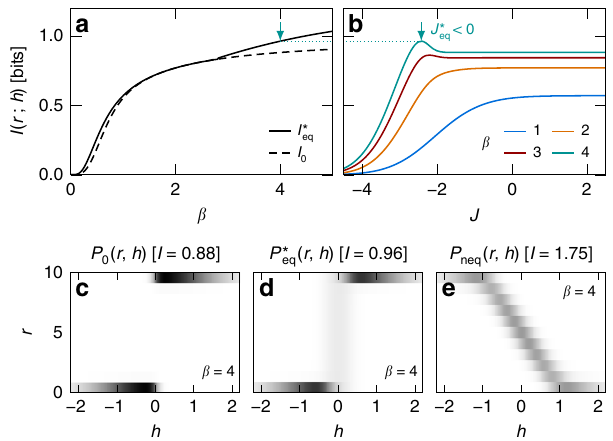
Fig. 5 Optimal sensing in the presence of time integration. Sensor interaction and energy consumption remain important for optimal sensing in the presence of time integration of sensor states by a population of readout molecules. We consider a two-sensor complex, driven by signal ffiffiffiffiffiffi p H = ( h , h ) with P ¼ e (cid:3) h 2 = 2 = 2 π and coupled to a readout population r H (Eqs. (11), (12)). a Mutual information between the signal and the readout population for noninteracting sensors (dashed) and optimal equilibrium sensors (solid). Independent sensors are always suboptimal. b Mutual information as a function of sensor coupling J at various sensor reliabilities β (see legend). The optimal equilibrium strategy changes from cooperativity ( J > 0) in the noisy limit to anticooperativity ( J < 0) in the low-noise limit. c – e Joint probability distribution of signal and readout population at β = 4 for three sensing systems: noninteracting c , optimal equilibrium ( d ), and near-optimal nonequilibrium ( e ) (cf. Fig. 4). Optimal equilibrium sensors use anticooperativity to increase the probability of the states + − and − + , which map to intermediate readout populations 0 <